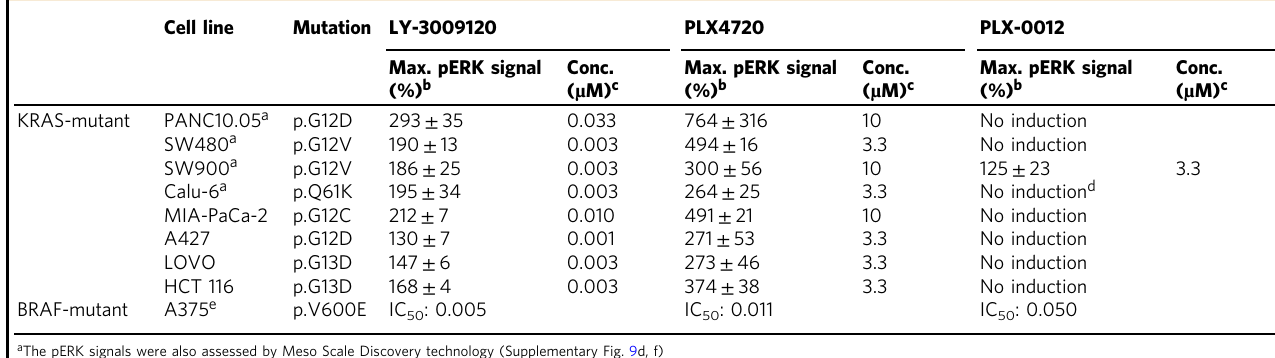
Table 1 Phospho-ERK pro fi ling of LY-3009120, PLX4720, and PLX-0012 paradox breaker in a panel of KRAS-mutant cancer cell